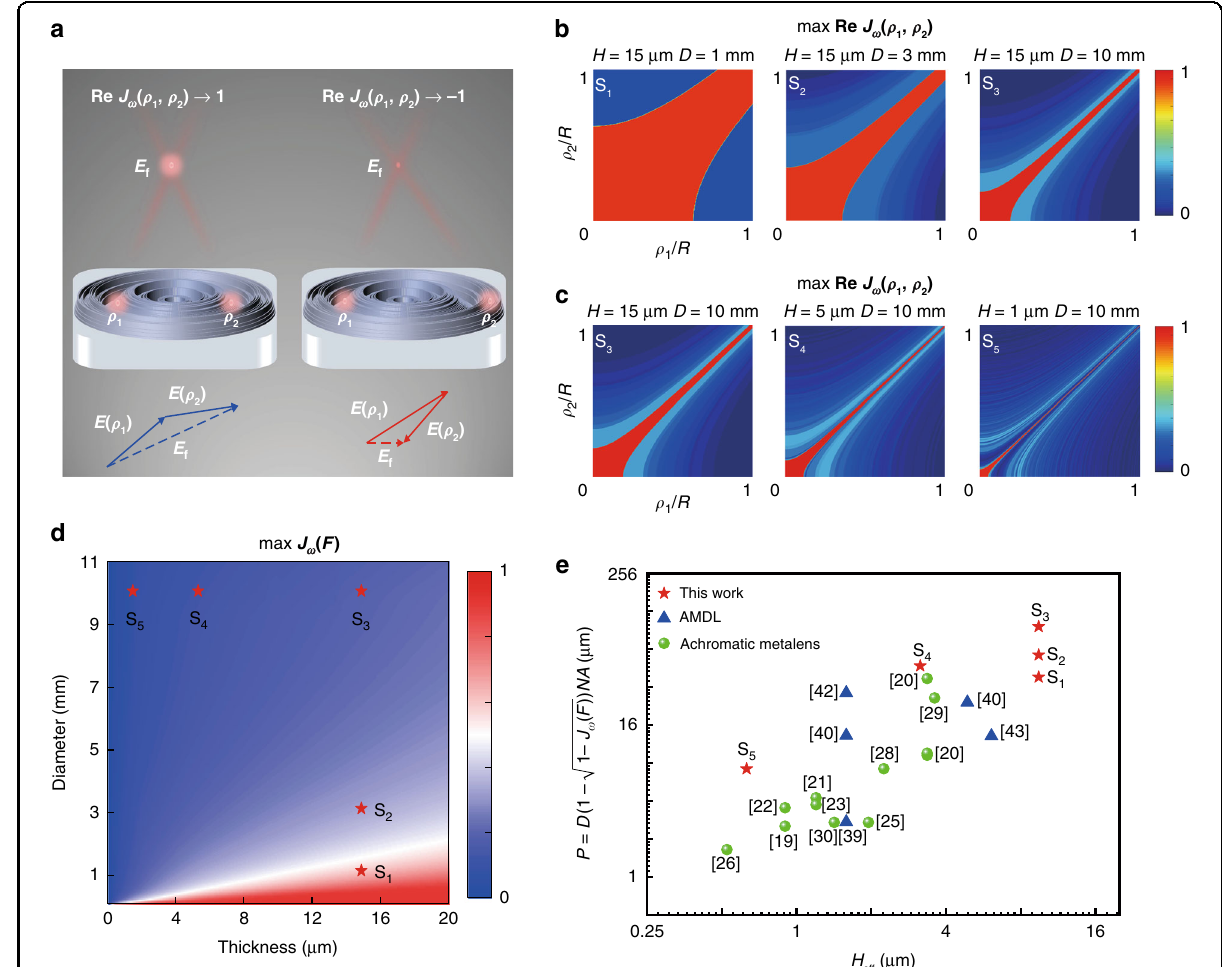
Fig. 1 The restriction relation between performance and parameters of AMDLs. a Schematics of the coherence of wave distortion in MDL. E f is the superposition of E ( ρ 1 ) and E ( ρ 2 ) at focus. The constructive E f and destructive E f are denoted as blue dashed lines and red dashed lines, respectively. b The distribution of max J ω ( ρ 1 , ρ 2 ) with thickness fi xed at 15 μ m and diameter equal to 1, 3, 10 mm, respectively. c The distribution of max J ω ( ρ 1 , ρ 2 ) with diameter fi xed at 10 mm and thickness equal to 15, 5, 1 μ m, respectively. d The max J ω ( F ) with respect to different samples in dimensions of diameter and thickness. e Comprehensive performance P of reported achromatic metalenses and AMDLs with respect to